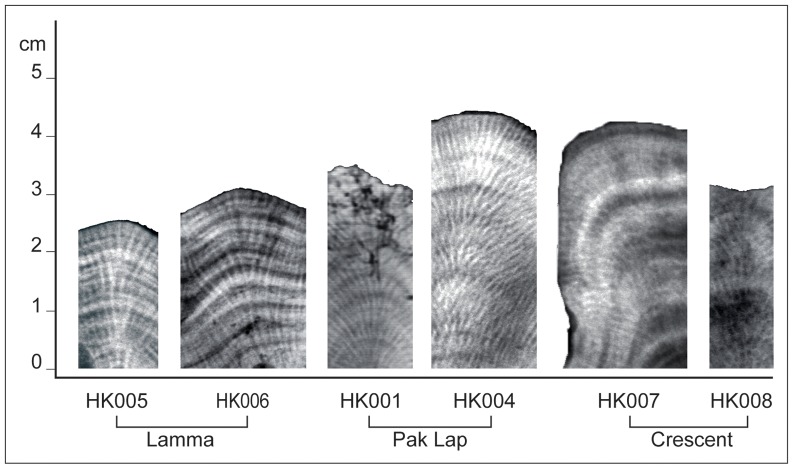
Coral X-radiograph negatives from the three regions: Lamma Island (HK005, HK006), Pak Lap Tsai (HK001, HK004), and Crescent Island (HK007, HK008).